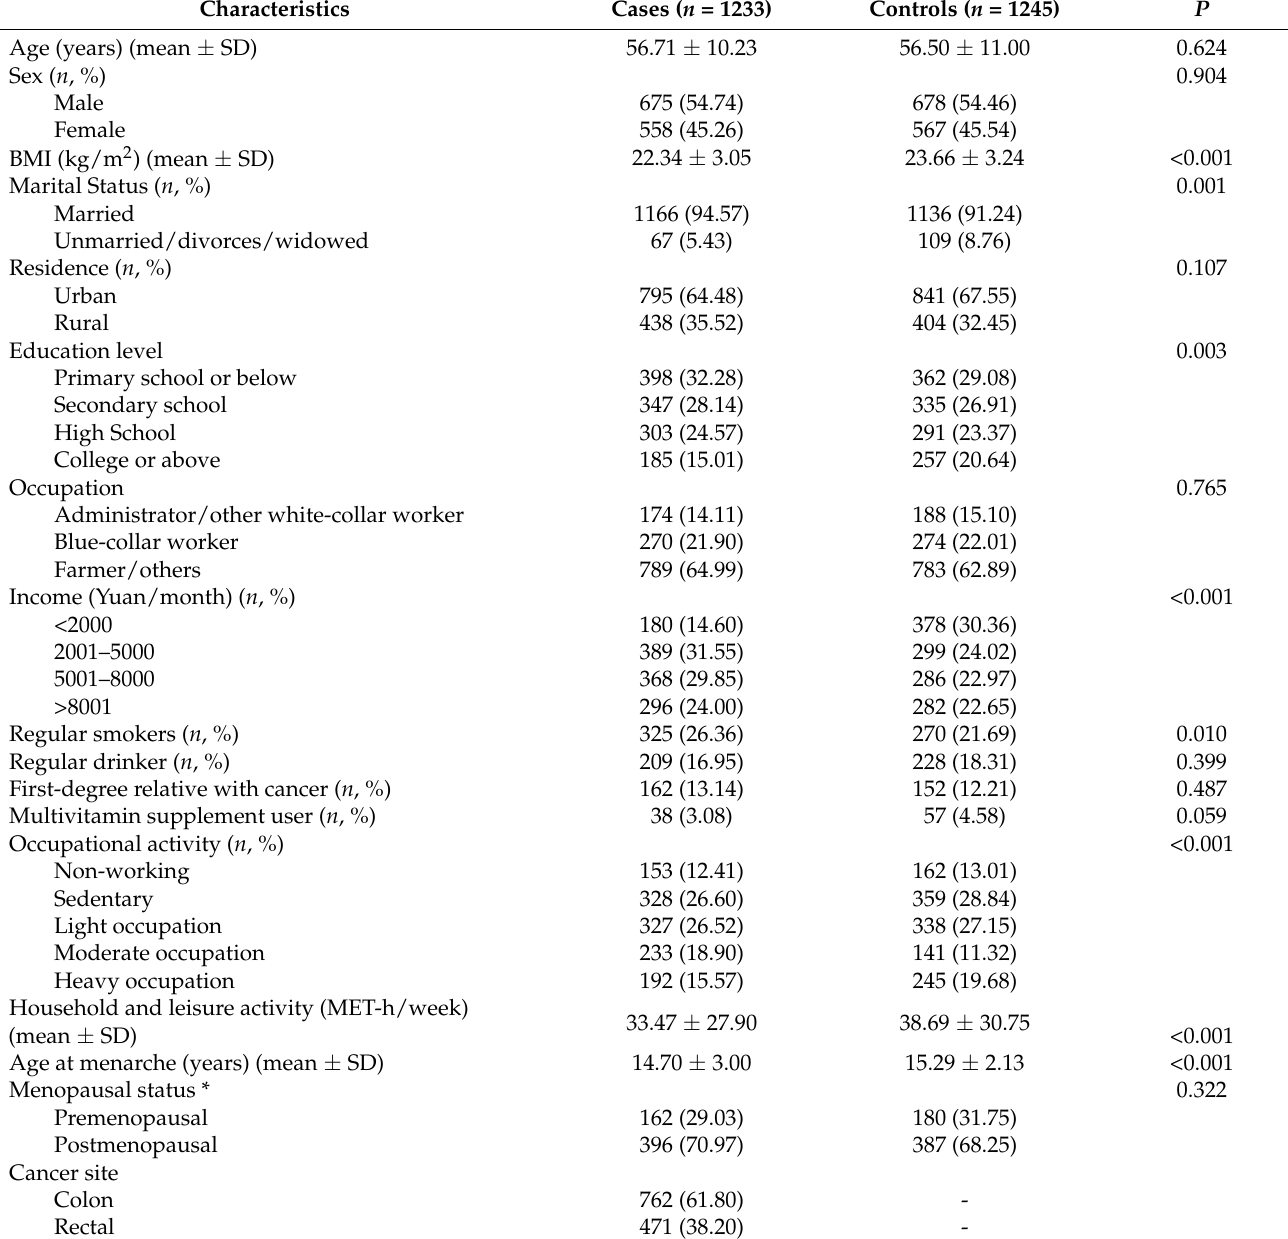
Table 1. The demographic factors of colorectal cancer cases and controls.